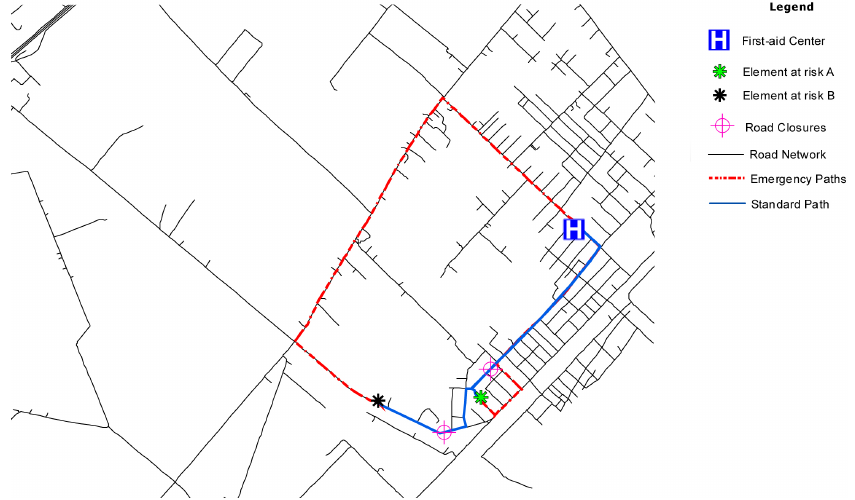
Figure 5. Graphical example of the elements (e.g. standard and emergency shortest paths, origin (i.e. first-aid centre) and destinations (i.e. buildings at risk), and node in which there are road closures) involved in Eqs. (1) and